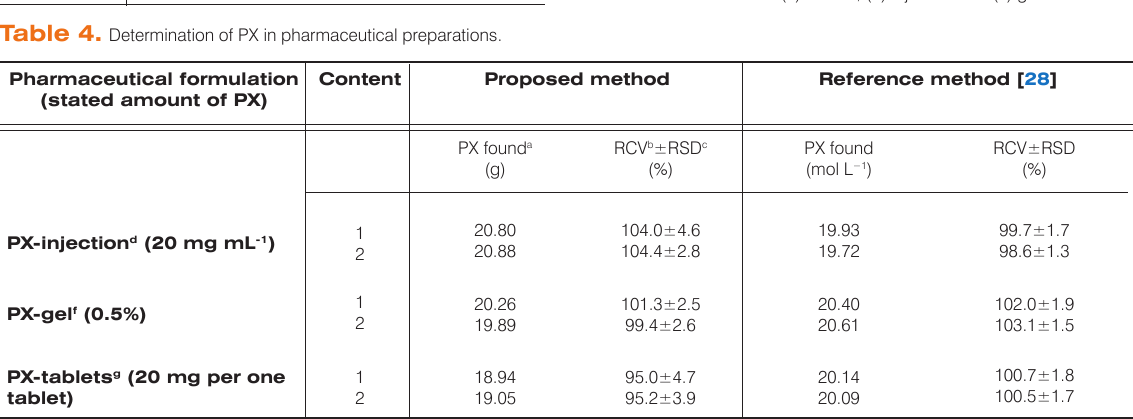
Figure 6. Typical response curves obtained after perturbing the stationary state in the BL reaction under optimized experimental conditions by addition of 50 µL of PX solution in (a) tablets; (b) injection and (c)